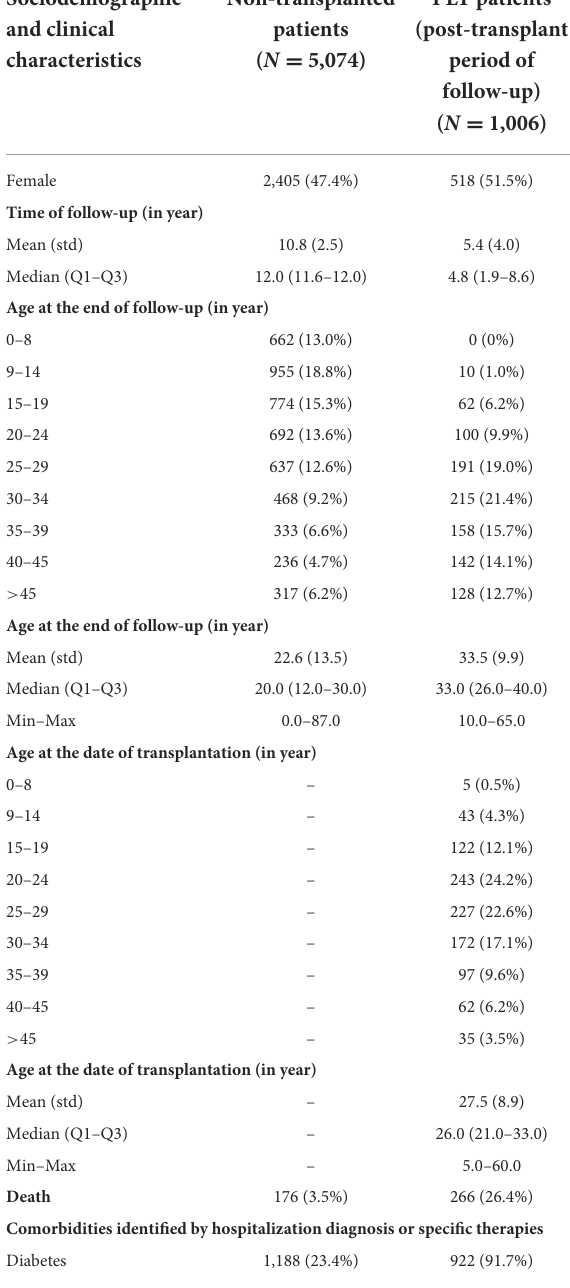
TABLE 1 Sociodemographic and clinical characteristics of non-transplanted and PLT pwCF. Sociodemographic and clinical